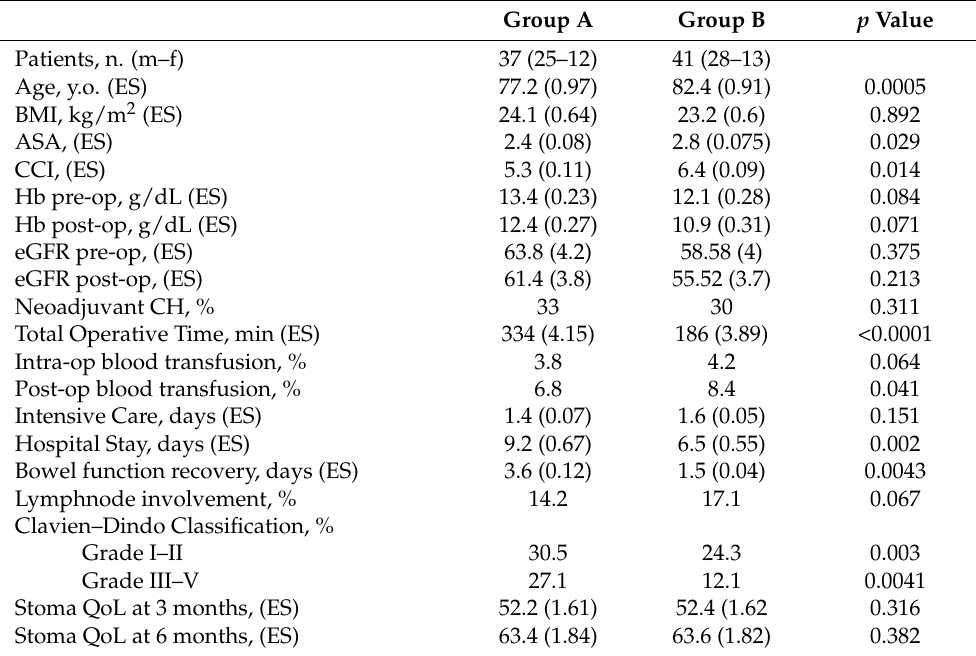
Table 1. Preoperative and post-operative results.